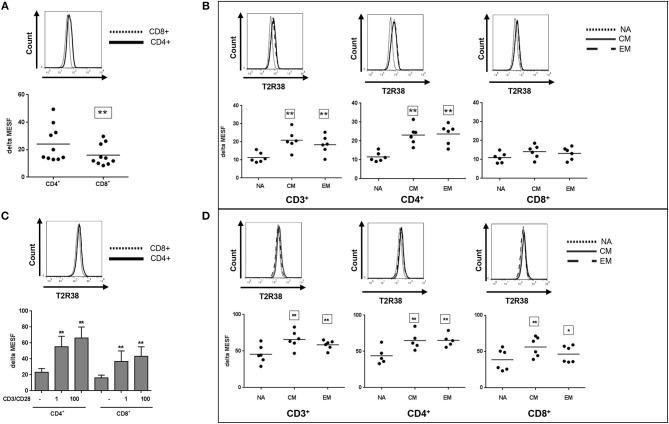
T2R38 expression status in T cell subsets. T2R38 expression was quantified in (A,B) freshly isolated cells (n ≥ 6) or (C,D) CD3/CD28-stimulated cells after 72 h (n ≥ 5). Each dot represents one donor, bars are means + SD. NA, naïve, CM, central memory, EM, effector memory cells. Representative histograms of different stains from one donor are shown. The gating strategy is given in Supplementary Figure S3. T2R38 expression (delta MESF) was assessed by Quantum Alexa Fluor 488 MESF beads in comparison to rabbit IgG isotype control. Significance of difference was calculated relatively to the respective control, *p < 0.05, **p < 0.01.